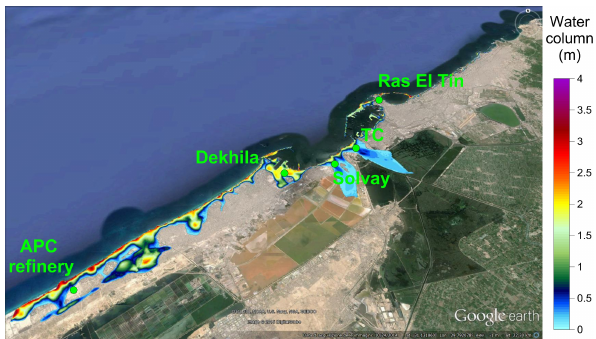
Figure 16. Aggregate field of water depth maxima on land (grid 4), obtained by combining the results of the WHA, EHA and CA sce- narios and superimposed on a Google Earth image. Tsunami simu- lations have been computed, assuming mean-sea-level conditions.